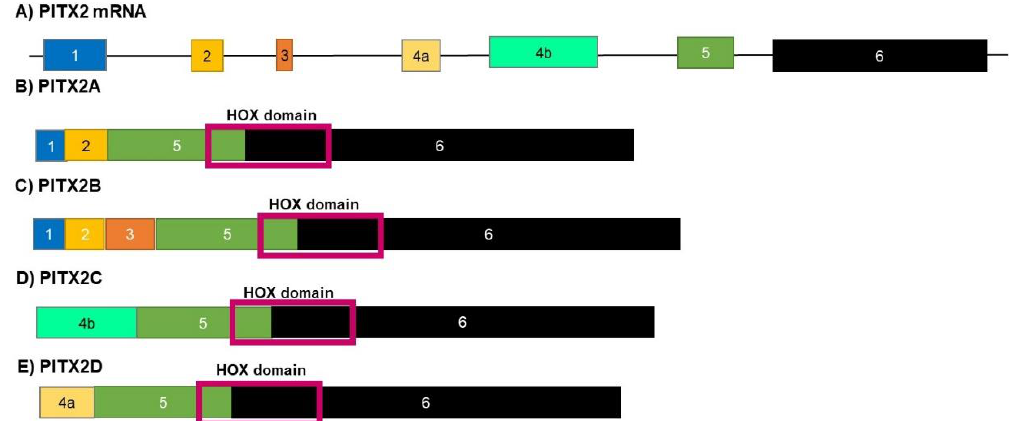
Figure 6. Isoforms of PITX2 . Alternate splicing of the PITX2 mRNA gives rise to four protein isoforms. Three of these isoforms ( A – C ) have a similar function, each inducing the transcription of different genes that stimulate growth and proliferation. The final isoform, isoform ( D ), acts as a negative regulator of the other three isoforms. The blocks in this figure represent the different exons making up each isoform. The size of the boxes indicates the relative size of the exons ( E ).